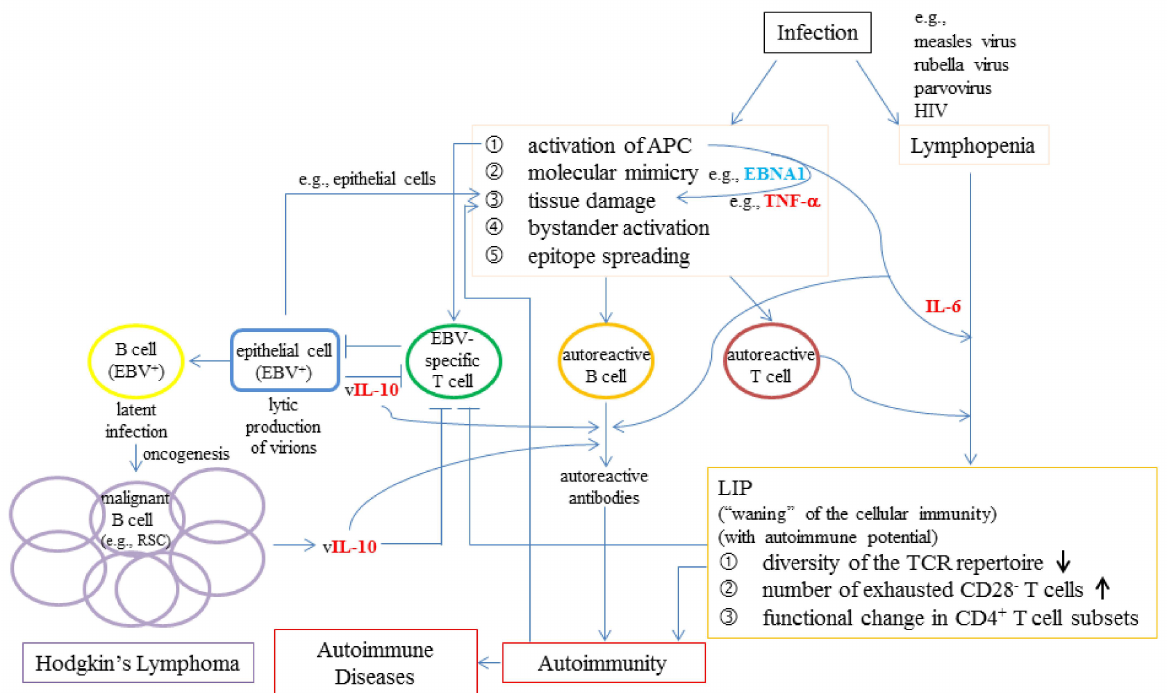
Figure 3. The possible roles of viral infections in LIP, autoimmunity, and lymphoproliferative conditions with focus on EBV. Infections could lead to lymphopenia and production of autoreactive T cells (brown circle) and B cells (orange circle) through a series of mechanisms. Under lymphopenic condition, IL-6 may drive LIP of autoreactive T cells. The LIP of autoreactive T cells and the production of autoantibodies increase autoimmunity that may further develop into autoimmune diseases. Cytokine TNF- α released from activated APCs could cause tissue damage. Activation of APCs by EBV infection results in the production of EBV-specific effector T cells such as cytotoxic T cells (green circle). EBV could infect both epithelial cells and B cells, although B cells are the primary targets. For illustration purpose only, it is shown that EBV virions produced from epithelial cells (blue rectangle) during the lytic phase of its life cycle could cause further damage of epithelial cells. EBV could also enter into a latent phase, during which the virus could remain silent in memory B cells (yellow circle). EBV has evolved various strategies to modulate the host immune response, such as production of viral IL-10 (vIL-10), which contribute to development of EBV + B cell lymphomas, such as RSC positive Hodgkin’s lymphoma. Arrows and T-bars indicate positive and negative effects,